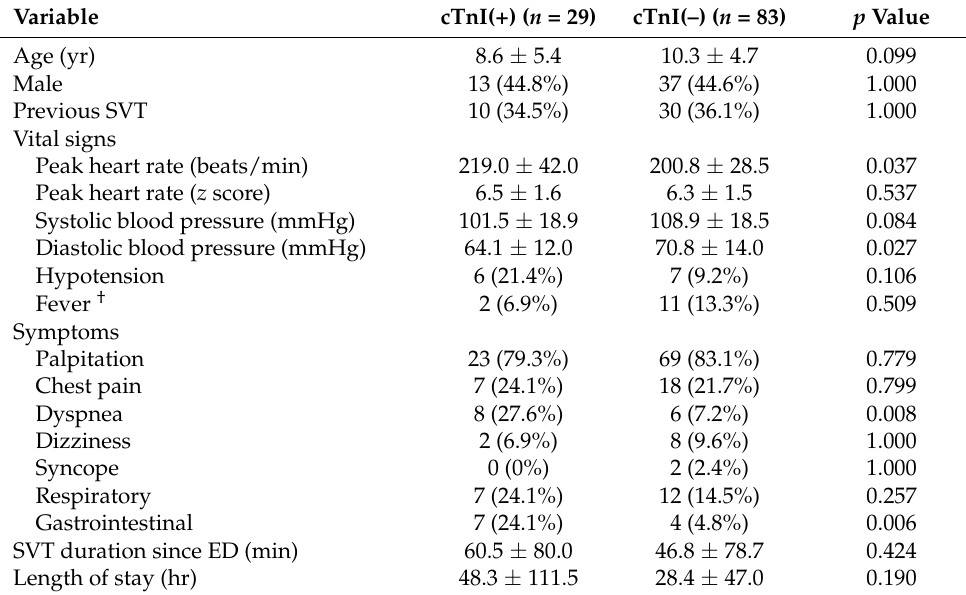
Table 1. Patient characteristics according to cTnI